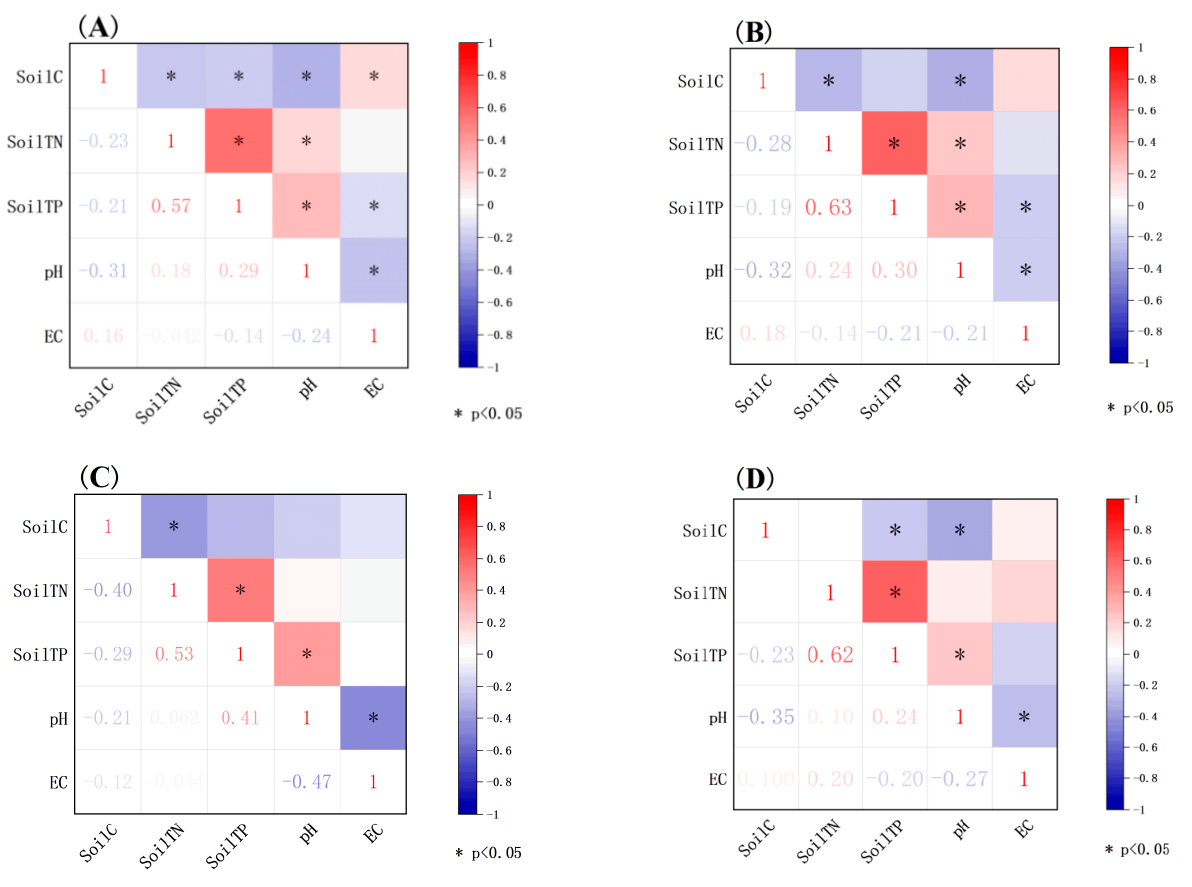
Figure 3. Correlation heat map of soil factors of desert halophytes in different functional